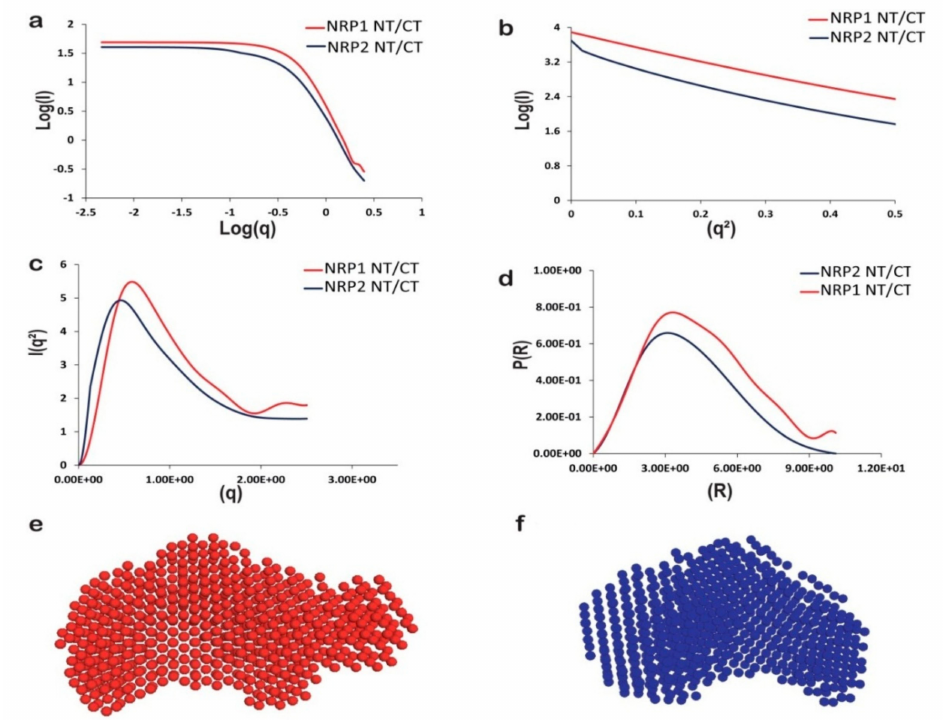
Figure 7. Small Angle X-ray Scattering (SAXS) profile and the generated envelope structures for AtNRP1 NT / CT and AtNRP2 NT / CT. ( a ) The double logarithmic plot for both AtNRP1 NT / CT and AtNRP2 NT / CT. ( b ) The Guinier plot analysis, showing the samples are monodispersed and homogeneous. ( c ) The Kratky plot showing the proteins to be elongated with flexible linker domains. ( d ) The Porod plot representing the pairwise distance distribution function. ( e ) The ab initio generated SAXS envelope of AtNRP1 NT / CT (red). ( f ) The ab initio generated SAXS envelope of AtNRP2 NT / CT